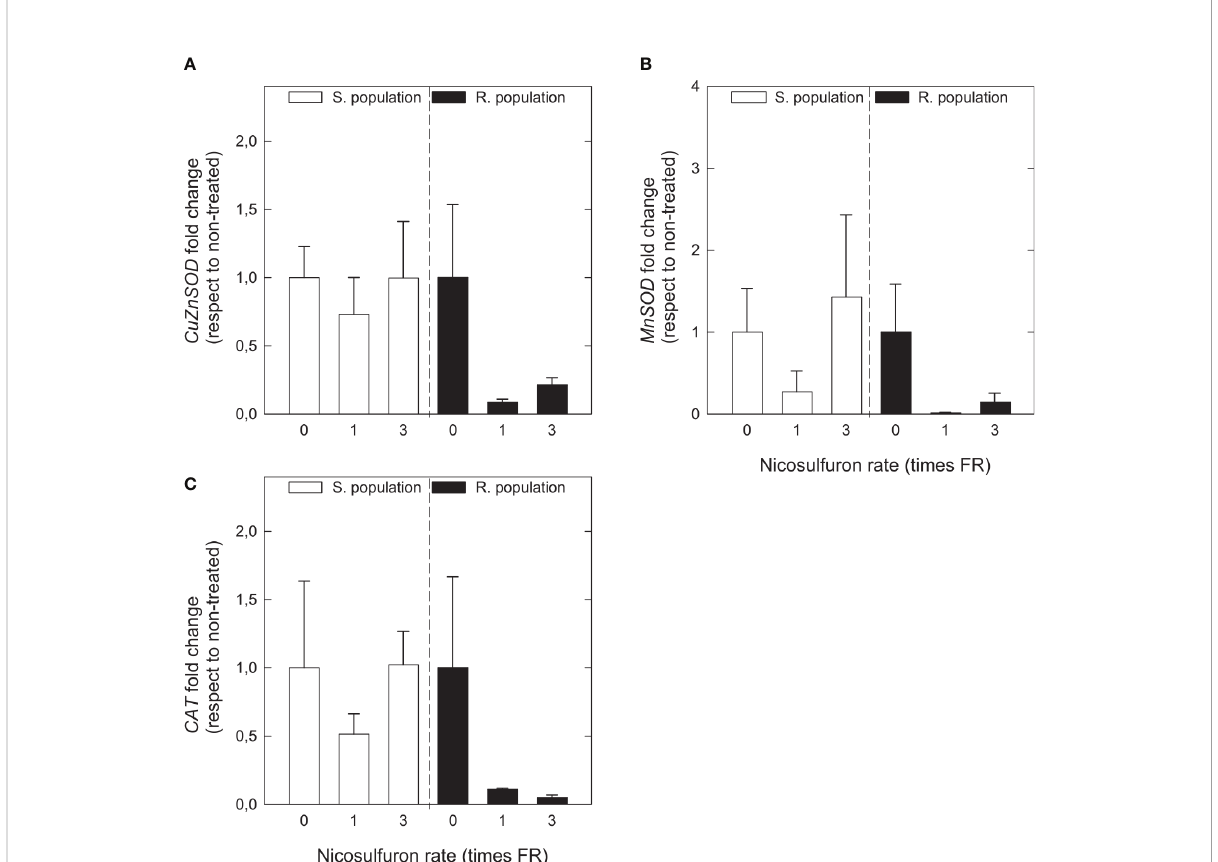
FIGURE 5 CuZn superoxide dismutase ( CuZnSOD ) gene expression (A) , Mn superoxide dismutase ( MnSOD ) gene expression (B) and catalase ( CAT ) gene expression (C) in Amaranthus palmeri sensitive (S, white) and resistant (R, black) populations), in relative fold change with respect to untreated plants of each population, treated with different nicosulfuron rates (X axis, times recommended fi eld rate or FR, FR = 0.06 kg ha -1 ). Mean ± SE (n = 4). For each population, no signi fi cant differences between treatments and their respective untreated were observed (Student ’ s t test, p value ≤